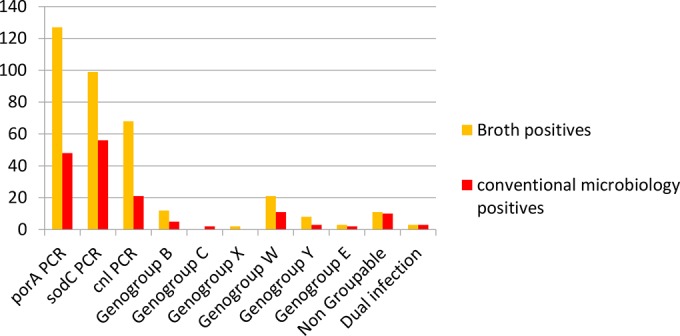
Comparison of N. meningitidis positivity using sodC and porA and genogroup characterization by real-time PCR on isolates after conventional microbiology versus culture overnight in Todd-Hewitt broth.